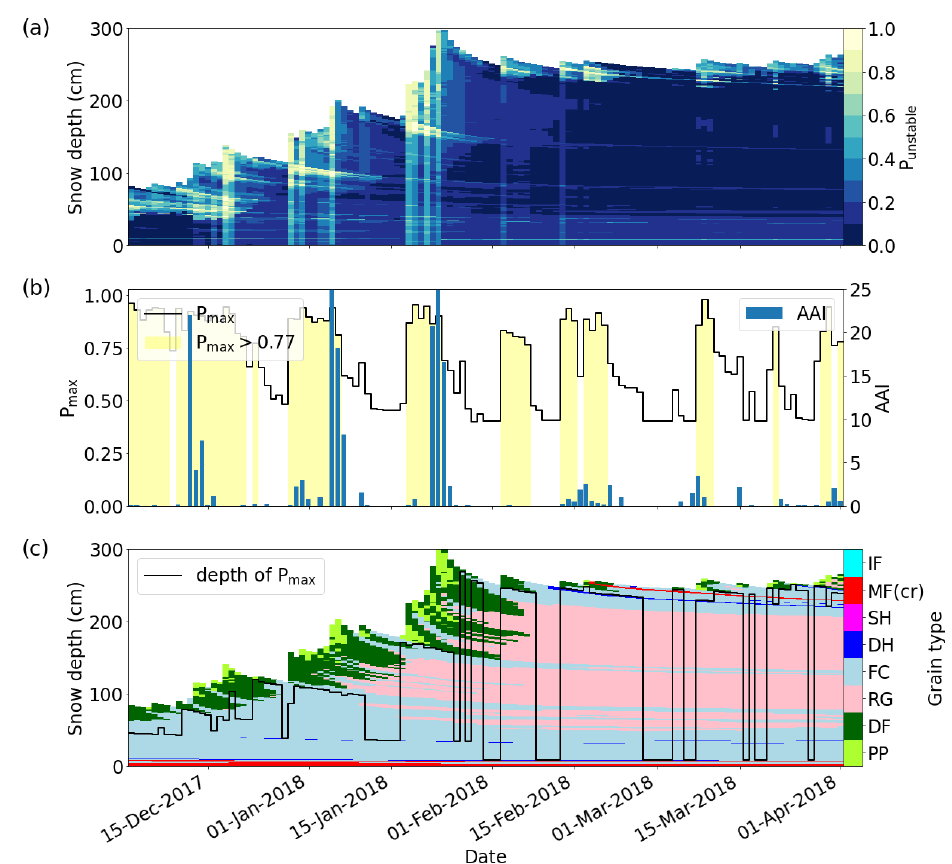
Figure 15. Evolution of (a) probability of instability P unstable (colors), (b) maximal values P max (black line) and avalanche activity index (AAI, blue bars), and (c) the depth of P max (black line) and grain types (colors) calculated for the simulated snow stratigraphy at the AWS Weissfluhjoch (WFJ, 2540ma . s . l . ) during the winter season 2017/18. Yellow-shaded areas in (b) indicate days with P max exceeding the threshold T = 0 .